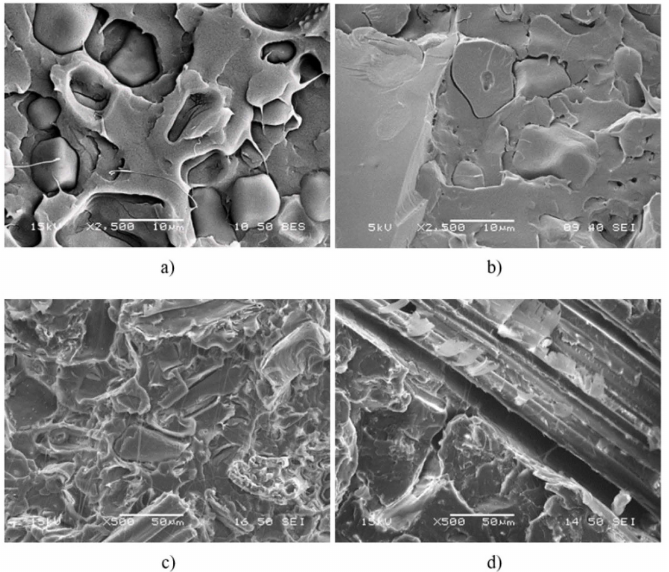
symbols without MAPLA, full symbols with MAPLA.